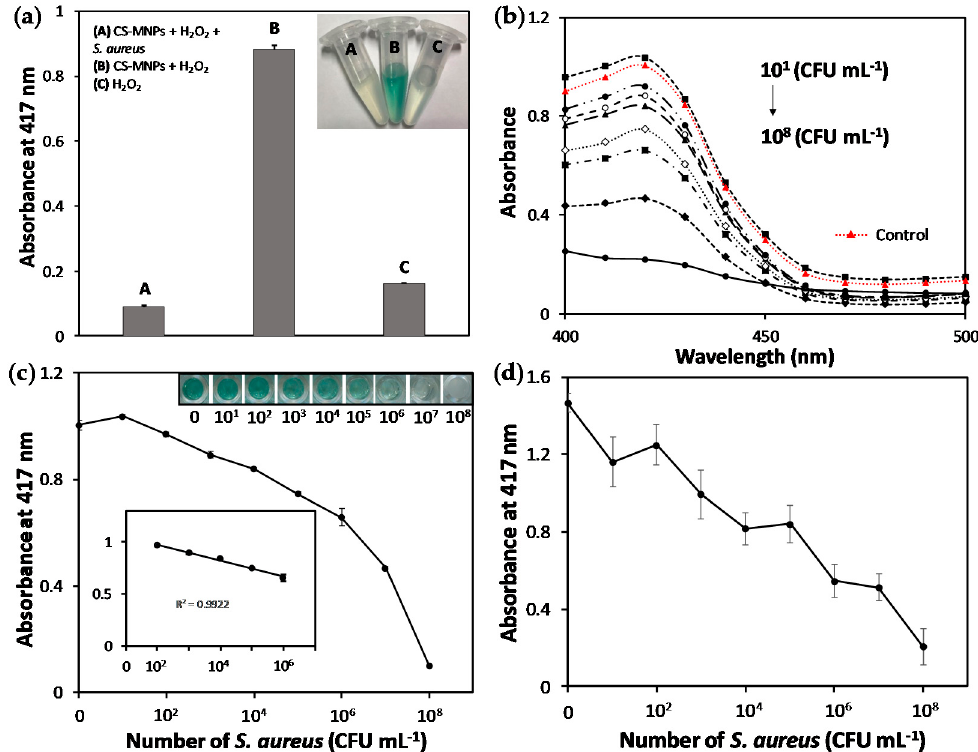
Figure 5. ( a ) Absorption intensity of the reaction leading to ABTS oxidation using CS-MNPs in the presence or absence of S. aureus (10 8 CFU mL − 1 ). Real photograph of the reaction solution is shown in the inset; ( b ) Absorption spectra of the reaction tube at various S. aureus concentrations ranging from 10 1 to 10 8 CFU mL − 1 ; ( c ) Absorption intensity of solutions obtained from the CS-MNPs-based assay at various S. aureus concentrations. Real photograph of the reaction solution is shown in the inset; ( d ) Absorption intensity of solutions obtained from the bare MNPs-based assay at various S. aureus concentrations.